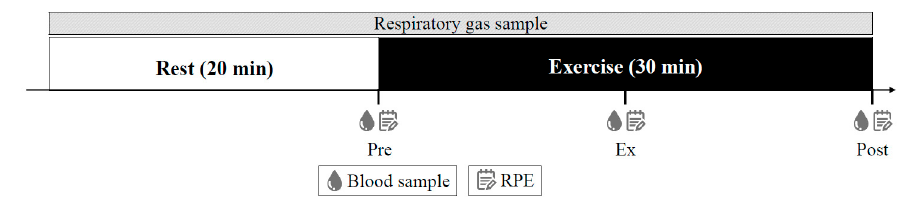
Figure 1. The schematic representation of the protocol. RPE, rating of perceived exertion; Pre, before exercise; Ex, 15 min during exercise; Post, immediately after exercise.